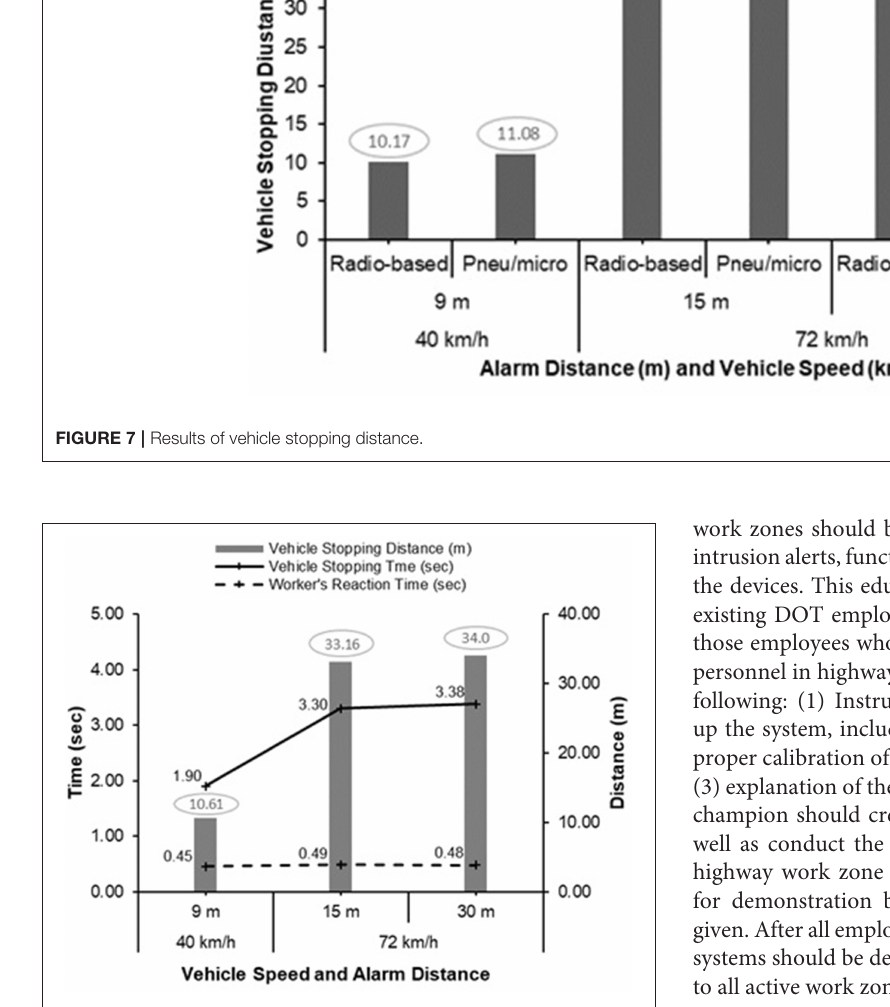
FIGURE 8 | Summary of experimental